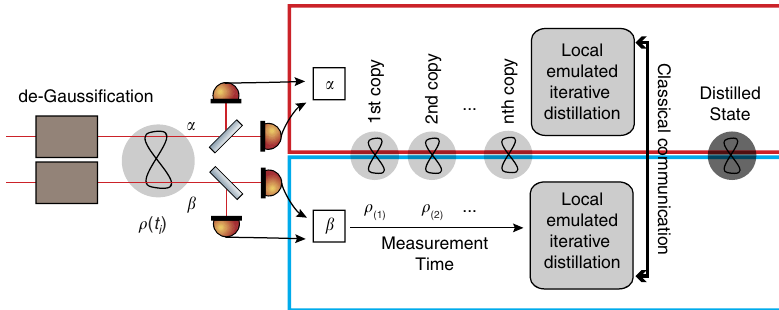
Figure 2 | Emulation of iterative Gaussification protocol. A single, continuously operated source distributes copies of the entangled and decohered states r to Alice and Bob. The states’ coherent amplitudes are locally measured with two out-of-phase BHDs each, the so-called eight-port homodyne detectors. By prolonging the measurement time any quantity of copies may be generated. An emulated iterative distillation protocol based on the local operations and classical communication is realized as described in the main text. In the end, Alice and Bob share data that are equivalent to that from measurements